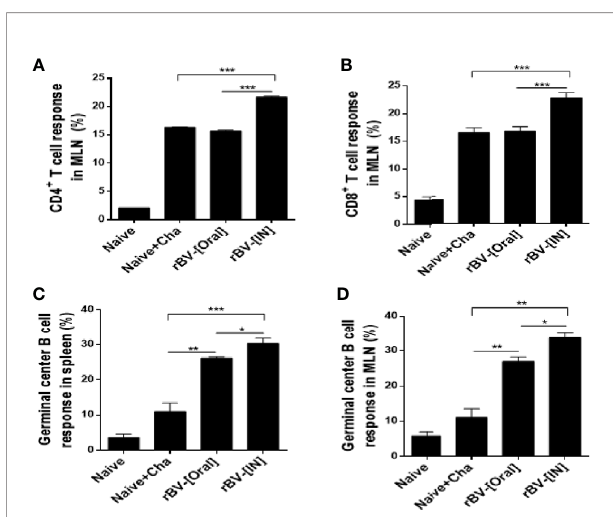
FIGURE 5 | Detection of CD4 + T cell, CD8 + T cell, and GC B cell. Mice were sacri fi ced at 16 dpi for spleen and MLN acquisition. Single cell suspensions of splenocytes and MLN cells were prepared and analyzed using fl ow cytometry to con fi rm proliferation of CD4 + T cell (A) , CD8 + T cell (B) , and GC B cell (C) in MLN. Splenic GC B cell activation was also con fi rmed using fl ow cytometry (D) . Data are presented as mean ± SD and asterisks denote statistical differences between groups. (* P < 0.05, ** P < 0.01, *** P < 0.001).